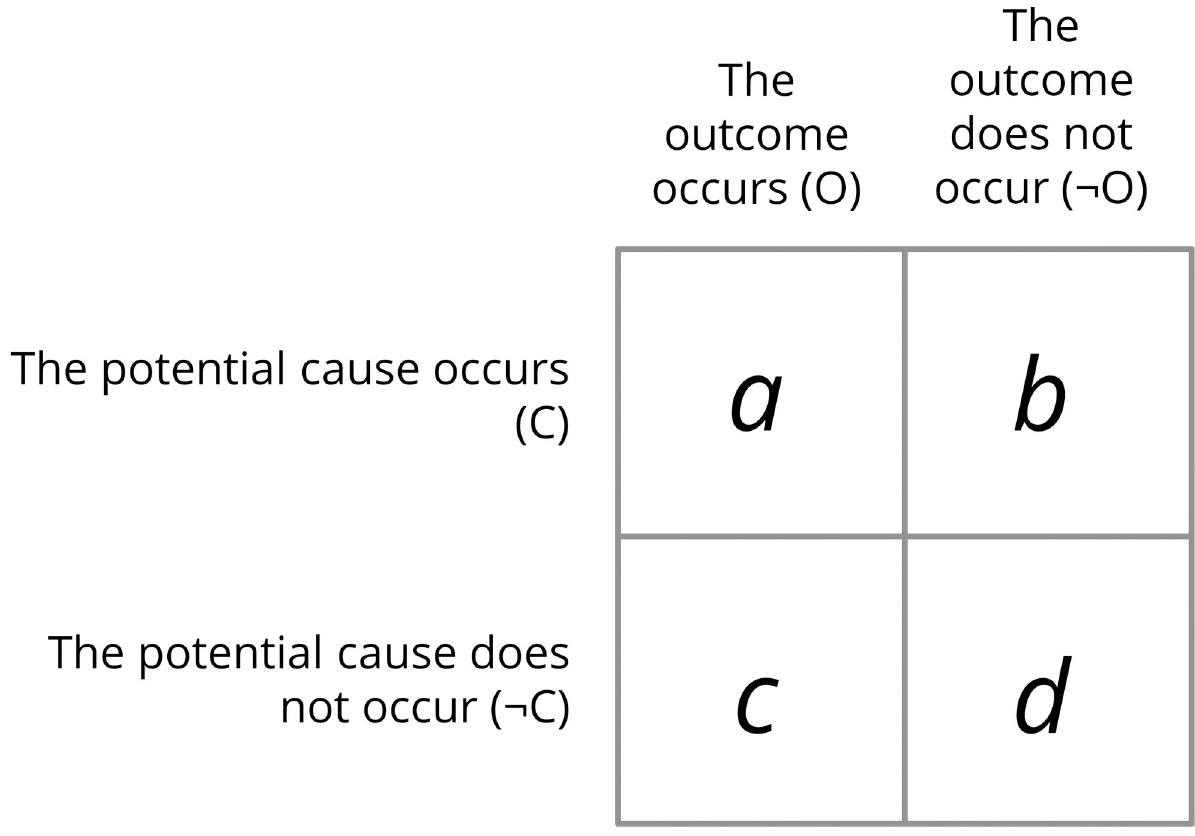
Fig 1. Contingency table for one potential cause and one